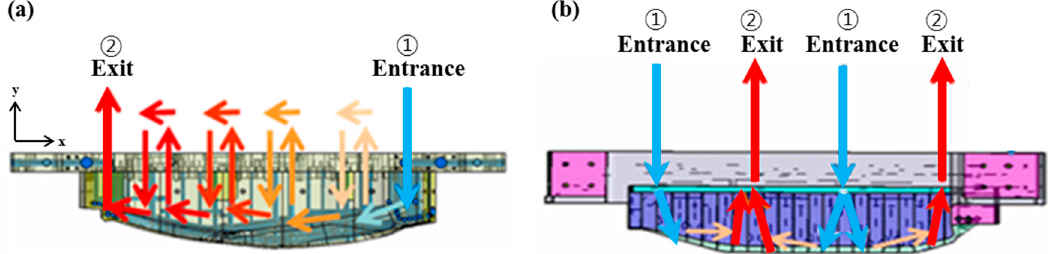
Figure 4. Cooling water flow in ( a ) conventional upper die and ( b ) slice upper die.